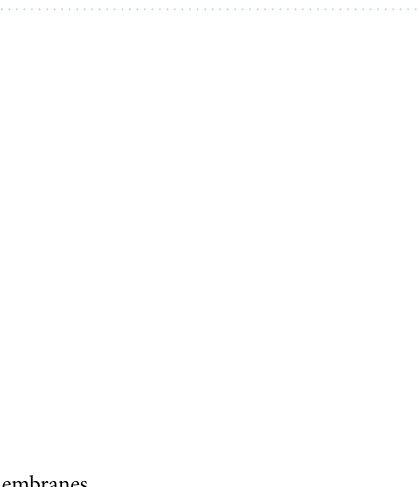
Figure 7. Mechanical stability of PS/pTAP composite blend